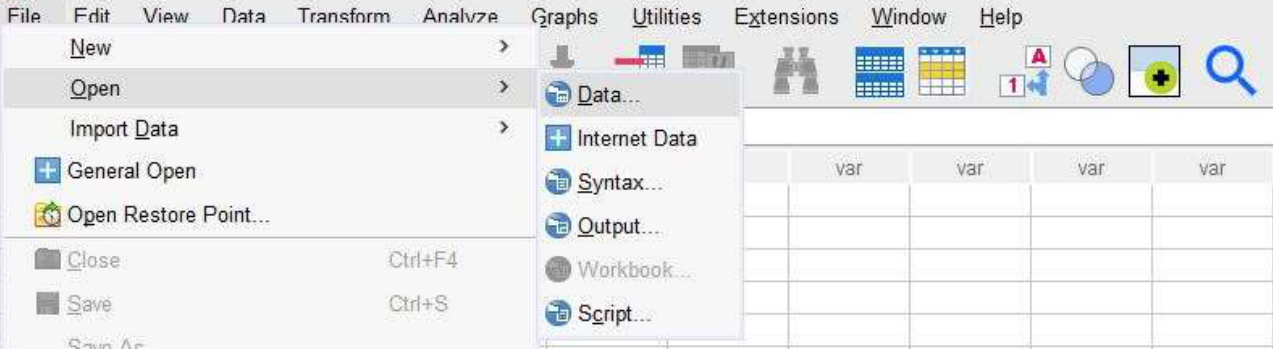
Figure 3. Open Data Menu.